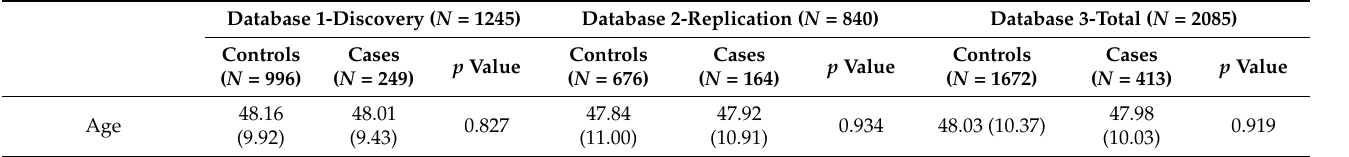
Table 1. Demographics of the study